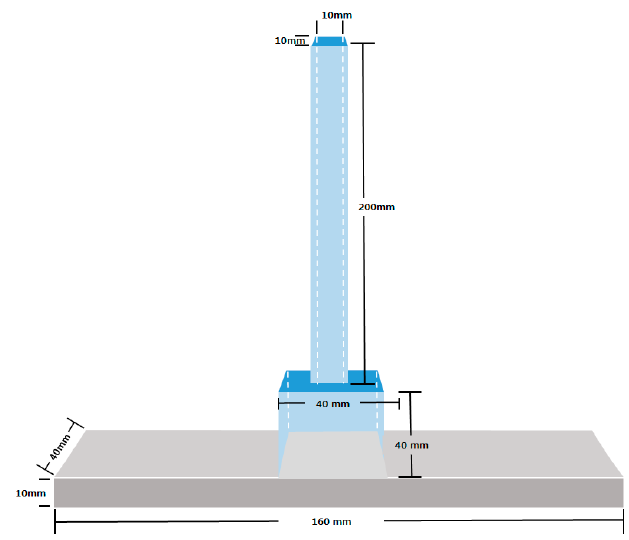
Figure 6. Tester of water tightness test.